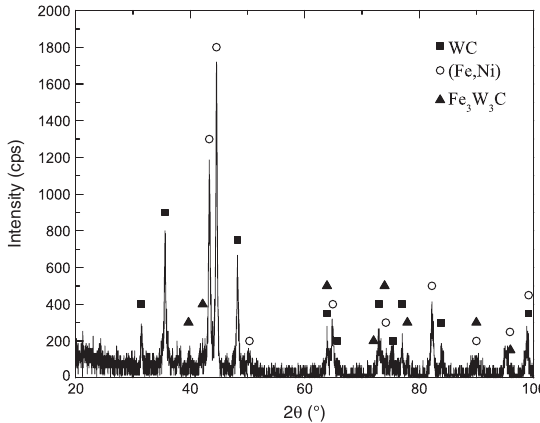
Figure 5: XRD patterns of the single-pass MMCs.